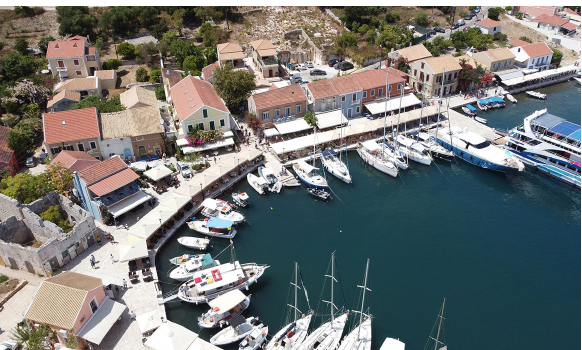
Figure 3 . Fiskardo Port, drone photo, bird's eye view, northern view.